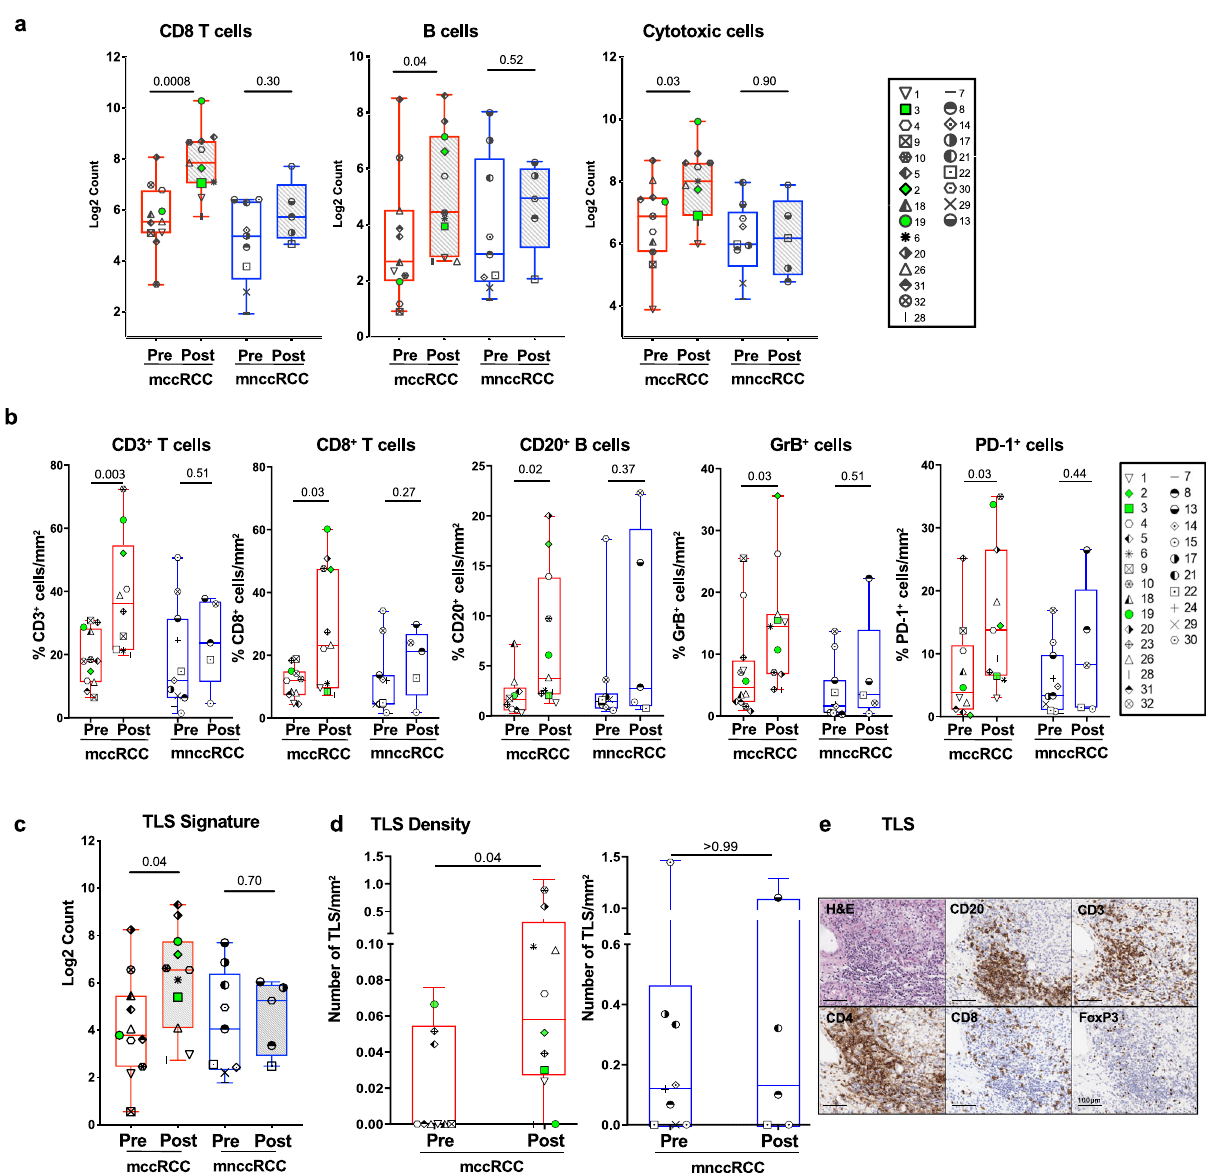
Fig. 4 Treatment with tremelimumab monotherapy or cryo-tremelimumab combination therapy leads to favorable changes in post-treatment tissue samples of patients with clear cell histology. a – d Pre and post-treatment tissue samples of patients with clear cell (mccRCC) and non-clear cell (mnccRCC) histology were analyzed by NanoString ( a and c , mccRCC: pre ( n = 11), post ( n = 11); mnccRCC: pre ( n = 9), post ( n = 5)) and IHC ( b , d and e , mccRCC: pre ( n = 13), post ( n = 11); mnccRCC: pre ( n = 11), post ( n = 5)). Box plots showing a in fi ltration of CD8 T cells, B cells, and cytotoxic cells,